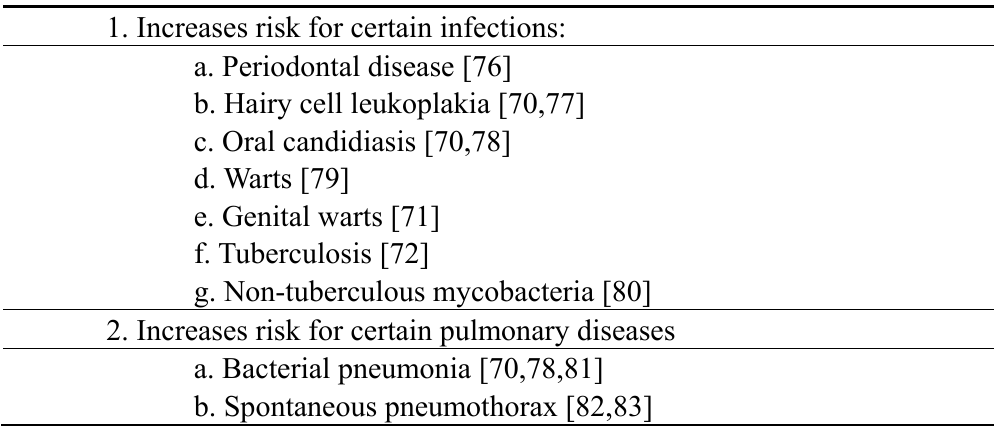
Table 2. Other effects of tobacco use in the HIV-infected